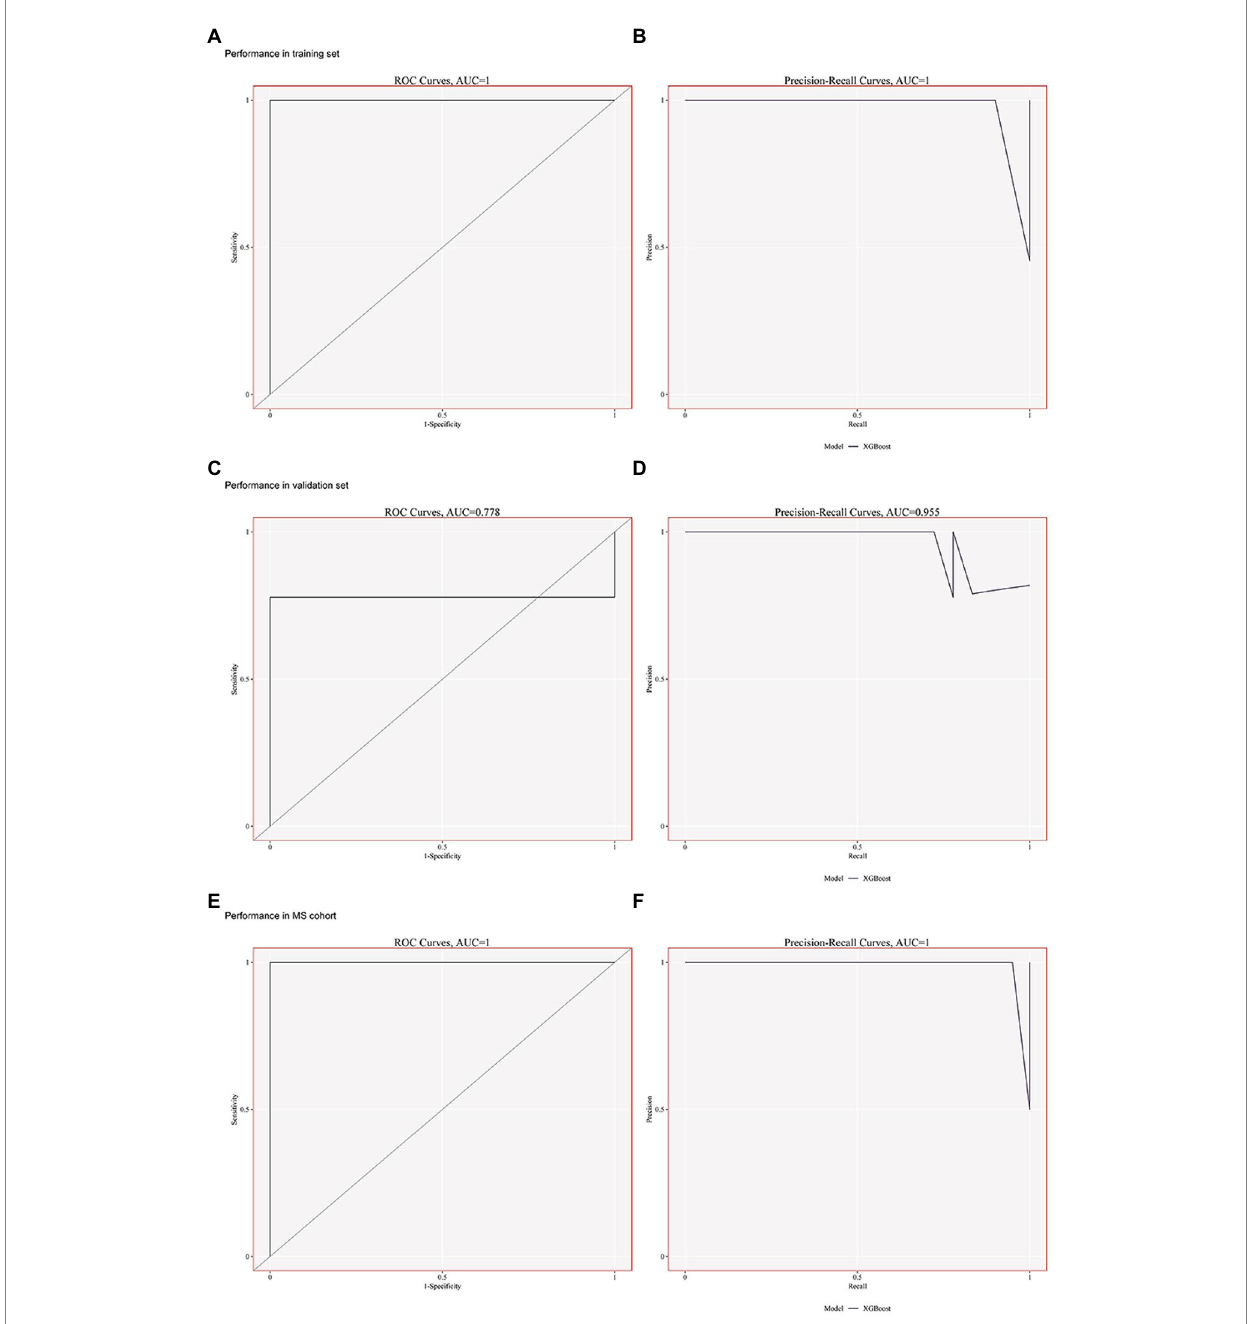
FIGURE 4 Building risk prediction models by XGBoost. ( A–B ) Performance of the ROC and PR curves in GSE30529 (training set). ( C–D ) Performance of the ROC and PR curves in GSE99340 (validation set). ( E–F ) Performance of ROC and PR curves in GSE98895 (MS